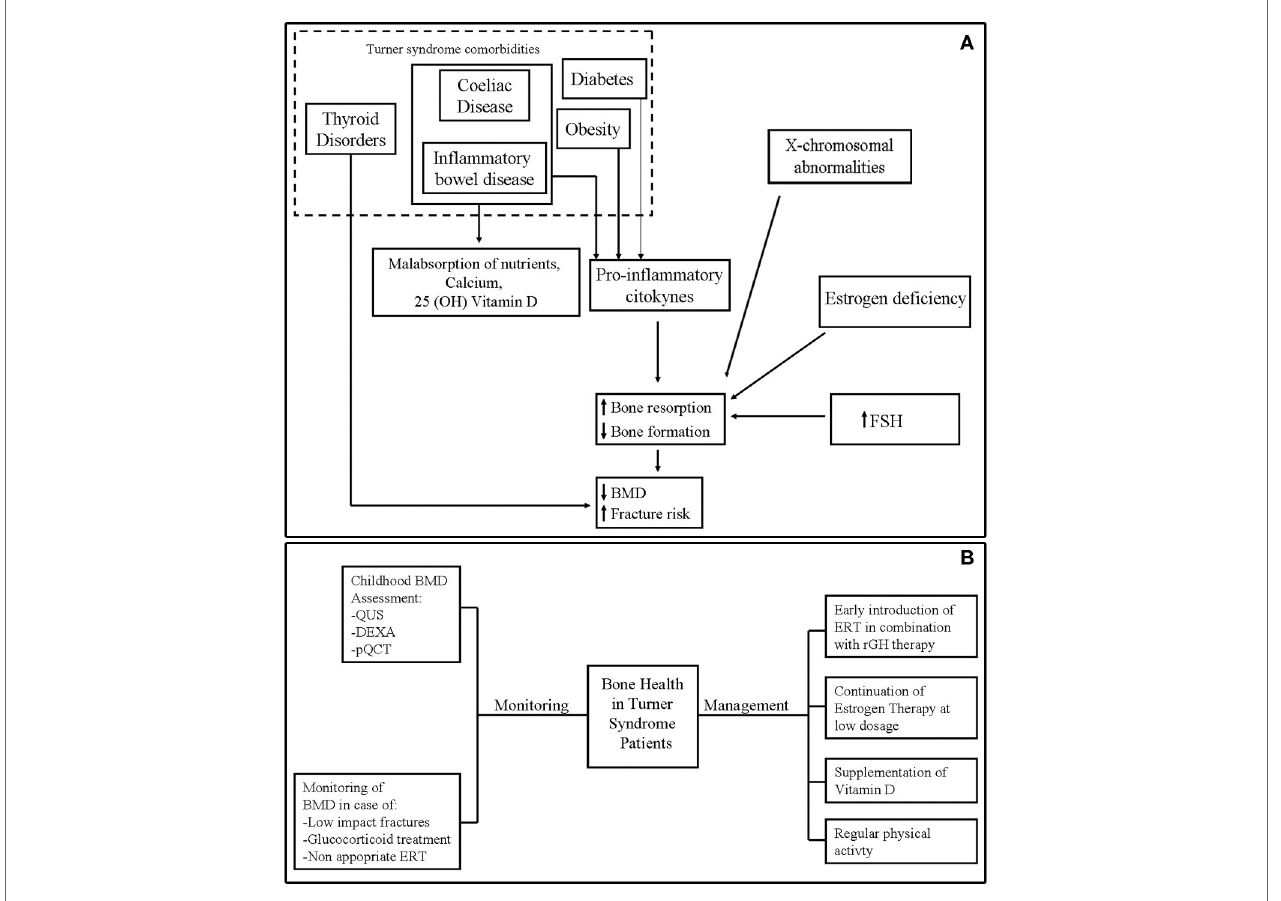
FiGURe 1 | (A) Potential mechanisms of bone fragility in Turner syndrome. (B) Monitoring and management of bone health in Turner